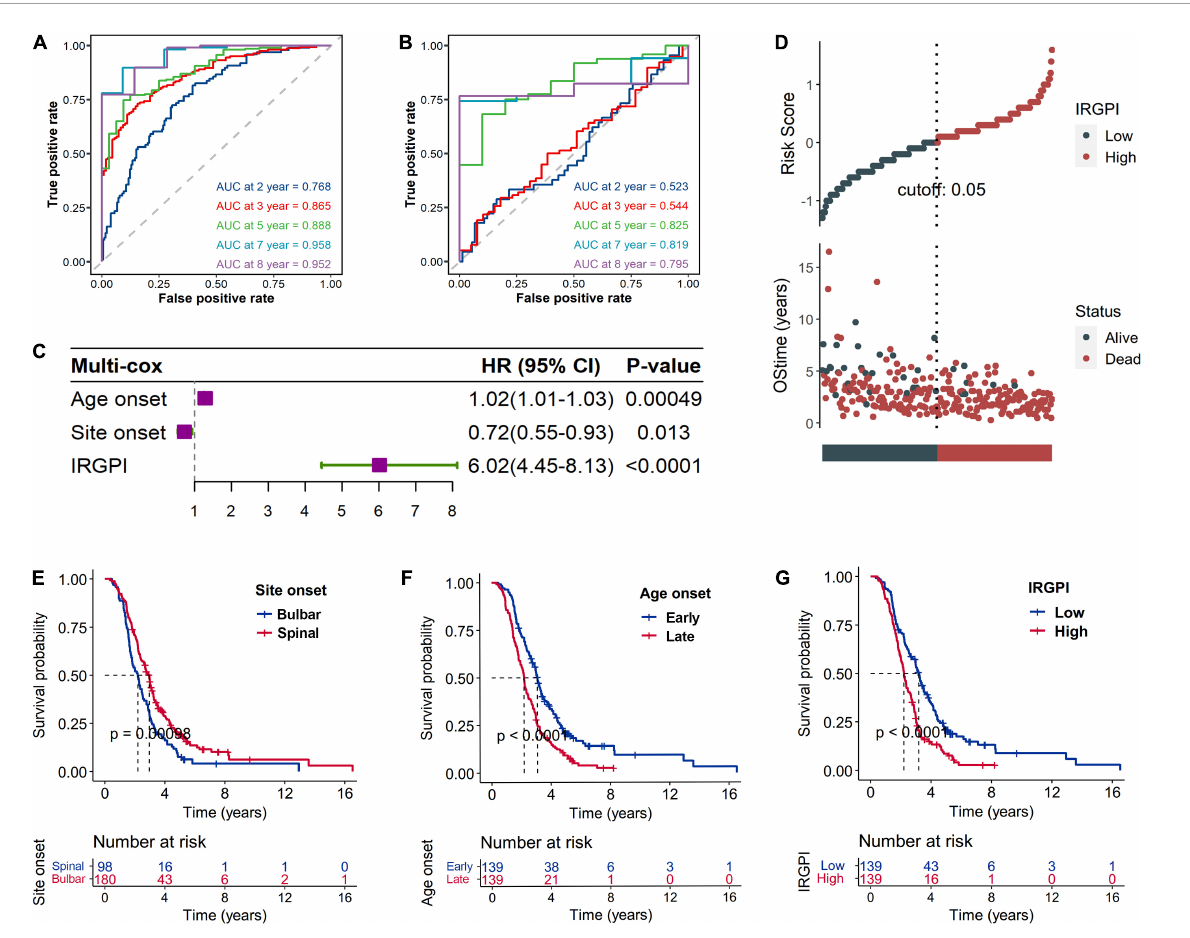
FIGURE3 Validation of the immune-related gene prognostic index (IRGPI) signature based on the testing cohort. The time-dependent ROC curves exhibited that the IRGPI signatures were with convincible performances in the training cohort (A) as well as the testing cohort (B) . Independent prognostic value of the IRGPI and clinical features was evaluated by multivariate Cox proportional hazard regression which was intuitively displayed in the forest plots (C) . The risk plot (D) demonstrated a clear distinguishment of survival status between IRGPI-high and -low subtypes with red dots representing dead patients and black ones alive, and shown the survival status becoming worse as the risk value increased. Kaplan–Meier (K-M) survival curves demonstrated that patients in the group of bulbar site-onset (E) , late age-onset (F), and IRGPI-high (G) had significantly worse overall survival (OS) than their counterpart. Number at risk is number of subjects exposed to endpoint risk at various time points, and the number of subjects exposed to the risk of endpoint events began to decrease over